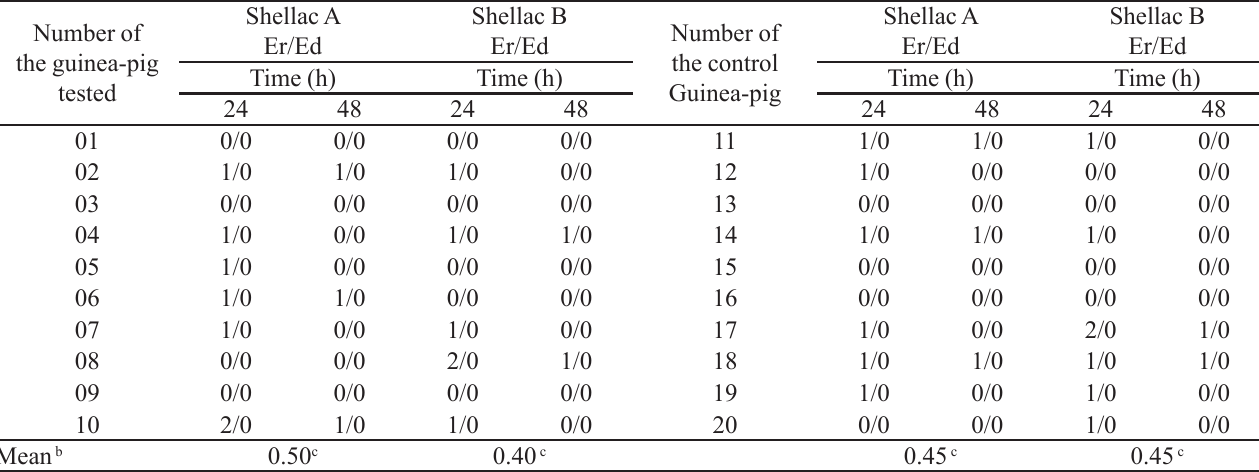
TABLE VII - Edema (Ed) and Erythema (Er) measured from tests of sensitization conducted according to the OECD method, after application of two samples (A and B) of a shellac paint. Ten guinea-pigs were used as tests for each shellac paint, as well as 10 guinea-pigs as the corresponding shellac-free controls a